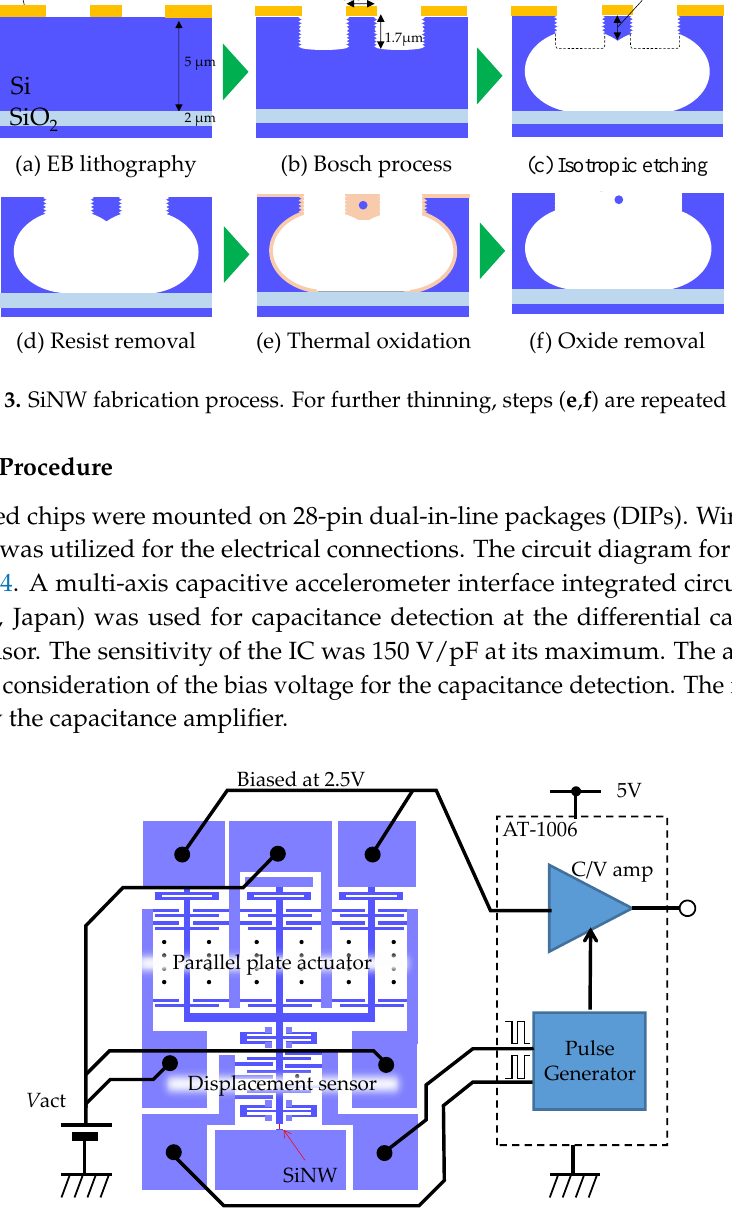
Figure 4. Tensile test circuit setup. The common input of interface integrated circuit (IC) is biased at 2.5 V, which is half of the power supply. The actuation voltage has an offset of 2.5 V.